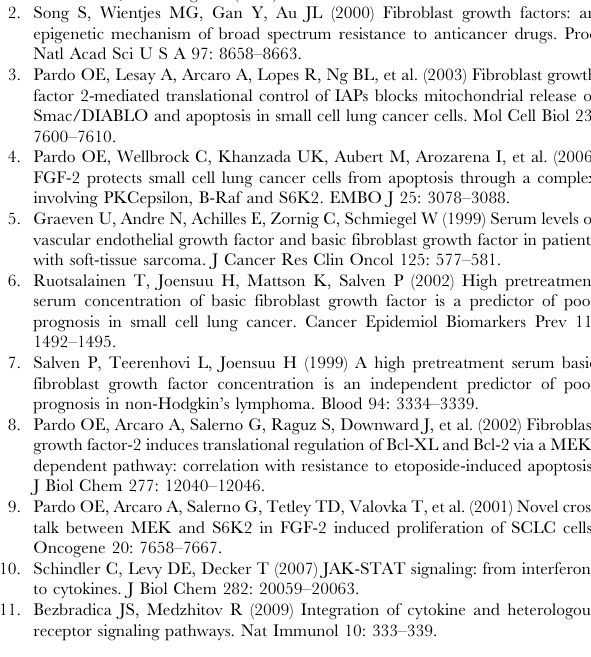
Figure S4 siRNA oligonucleotides can specifically knockdown TYK2, STAT1, STAT3 and STAT5A/B in U2OS cells. U2OS cells were transfected with 75 nM siRNA using DharmaFECT II. After 48 hours, proteins were extracted